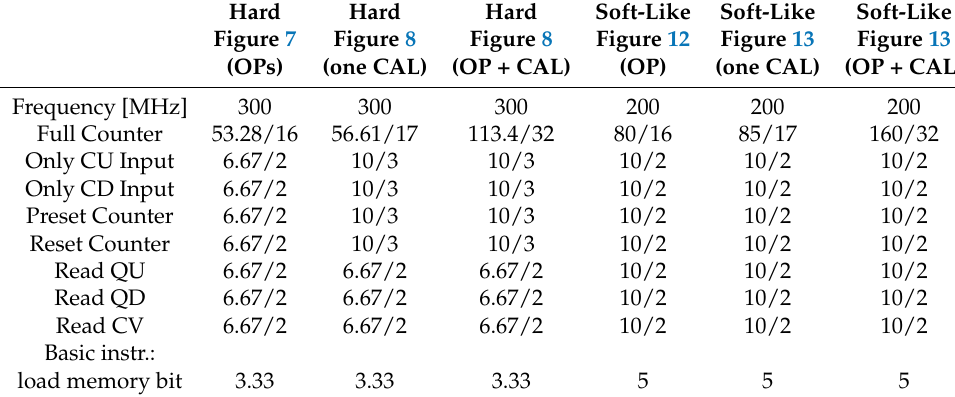
Table 5. Comparison of execution times for proposed in the paper